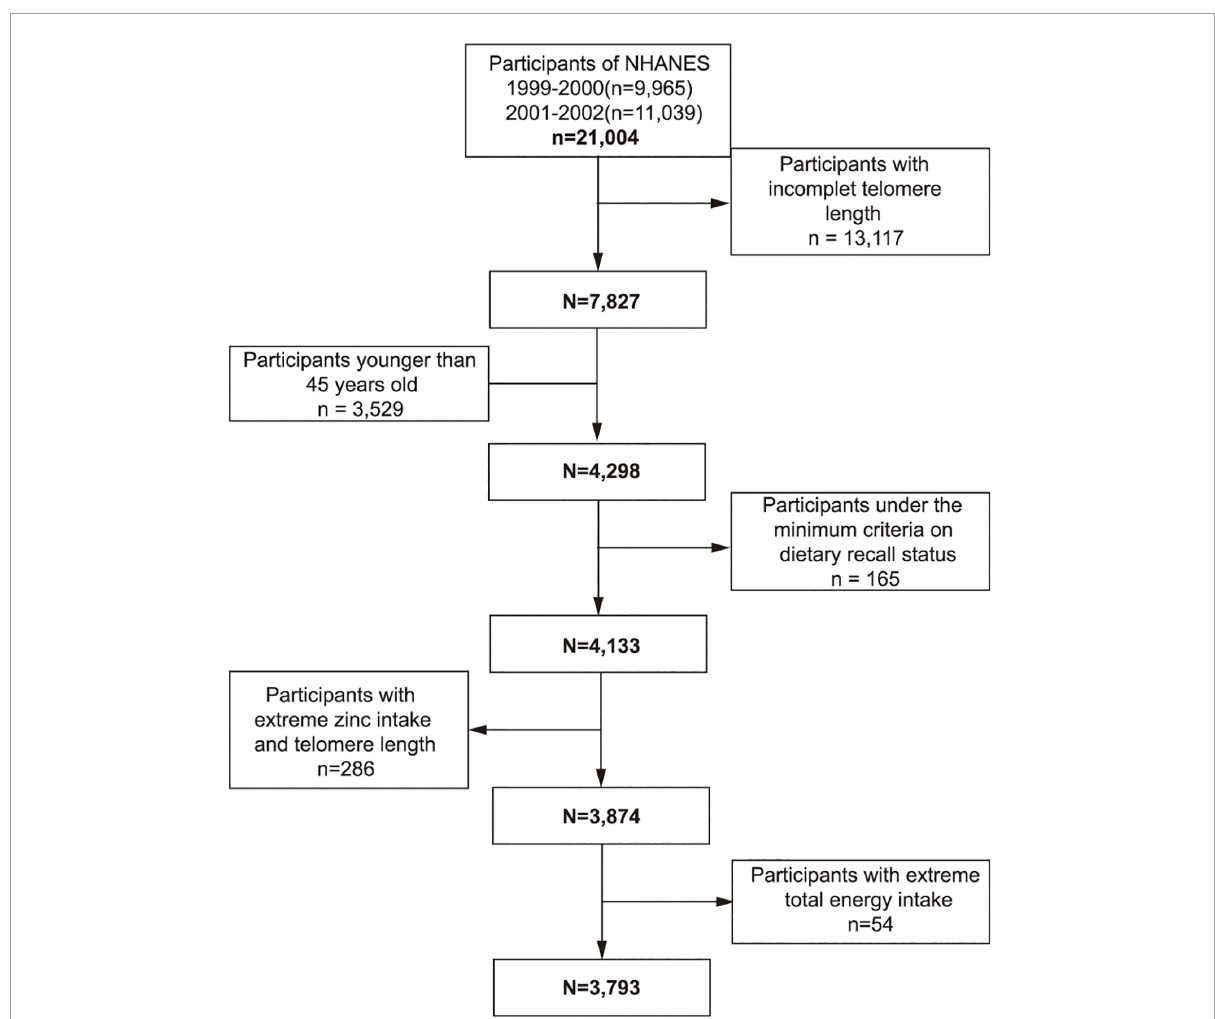
FIGURE1 Study flowchart. Flowchart showing study participant selection. Of 21,004 participants in the 1999–2002 National Health and Nutrition Examination Survey (NHANES), 3,793 remained after fulfilling inclusion and exclusion